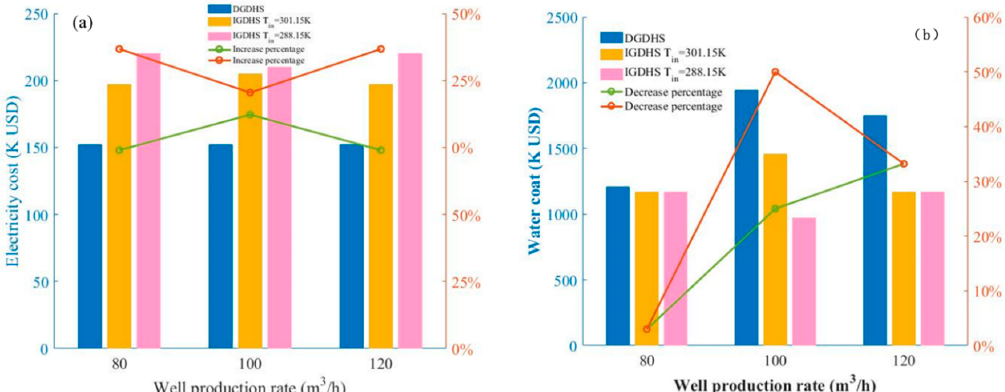
Figure 14. Annual power consumption of different geothermal heating systems: ( a ) electricity cost; ( b ) water cost.